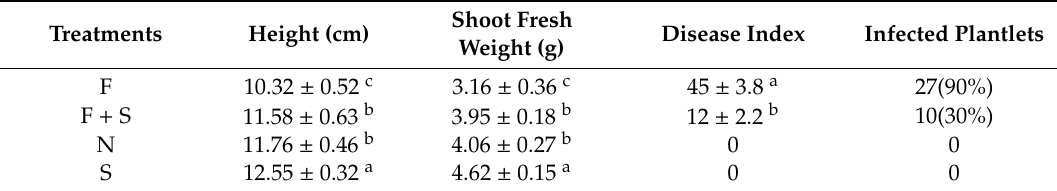
Table 1. Height, shoot fresh weight, disease index (DI), and number of infected plantlets with four treatments in greenhouse biocontrol assay.